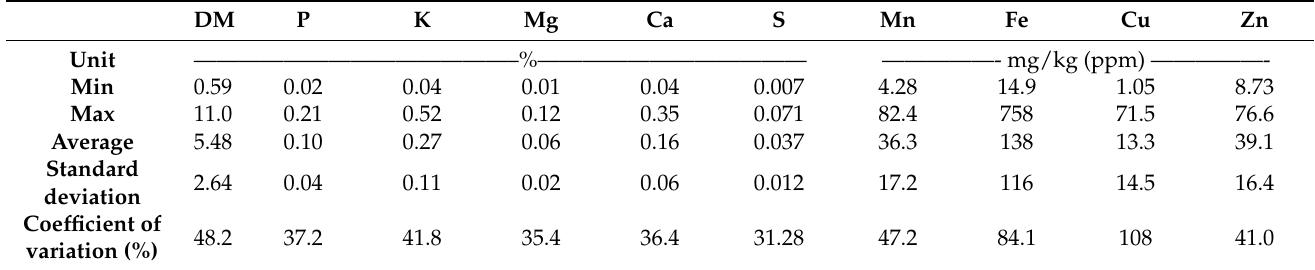
Table 1. Descriptive statistics for dry matter content (DM) and element concentrations in 62 liquid manure and biogas digestate samples, determined by the standard lab procedure (values are expressed on a fresh weight